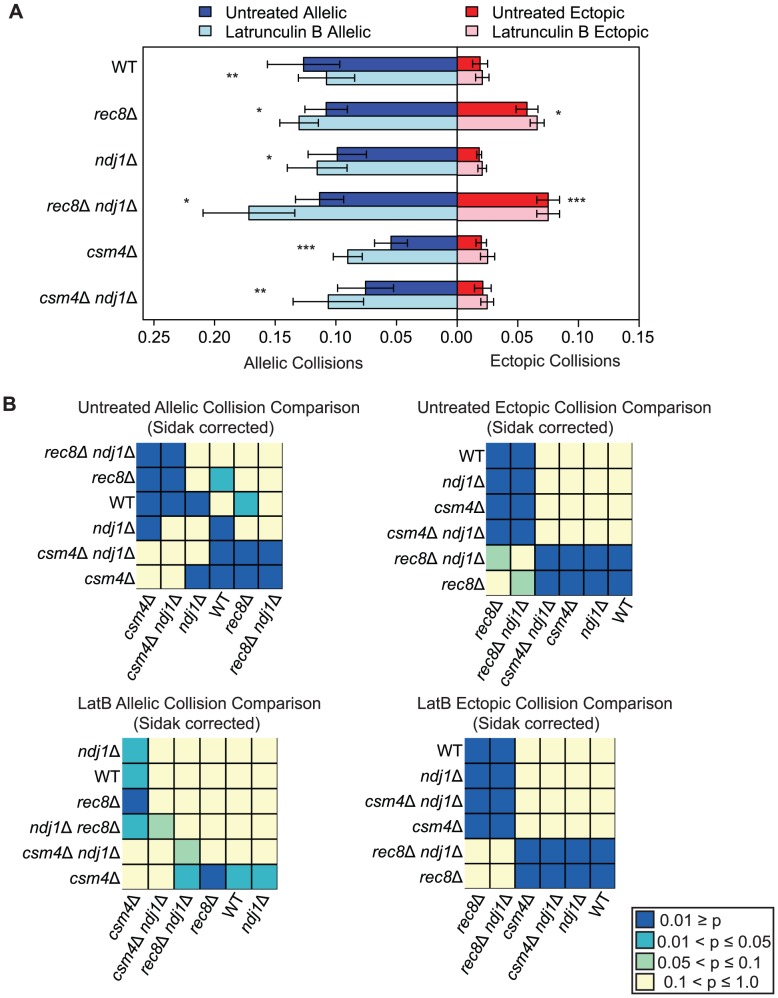
Elevated levels of nonspecific collisions in rec8Δ do not require Ndj1-dependent telomere attachments to the NE.A. Analysis of allelic and ectopic collision levels in rec8Δ, ndj1Δ, ndj1Δ rec8Δ, csm4Δ, and ndj1Δ csm4Δ mutants with Lat B treatment. Graph parameters are as described as in Figure 3. B. Heatmap of Sidak adjusted P-values from Student's t-test comparing collision levels between relevant mutants in untreated and Lat B treated cells.